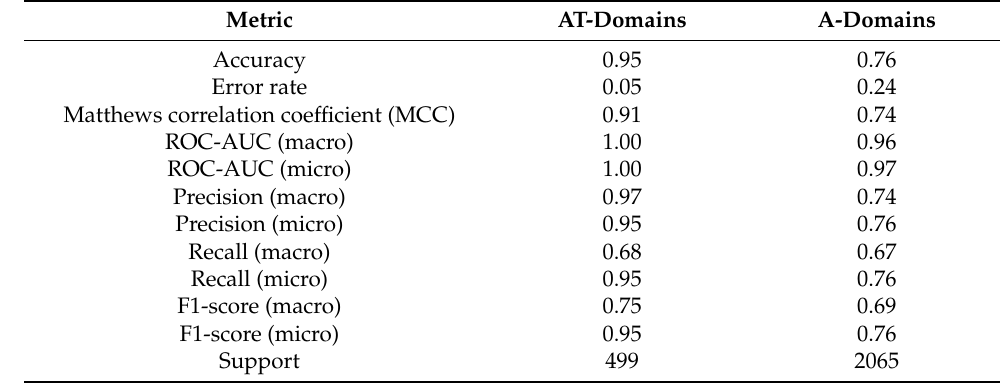
Table 6. Performance metrics for the classification of AT- and A-domain substrates. ROC-AUC refers to the area under the receiver operating characteristic